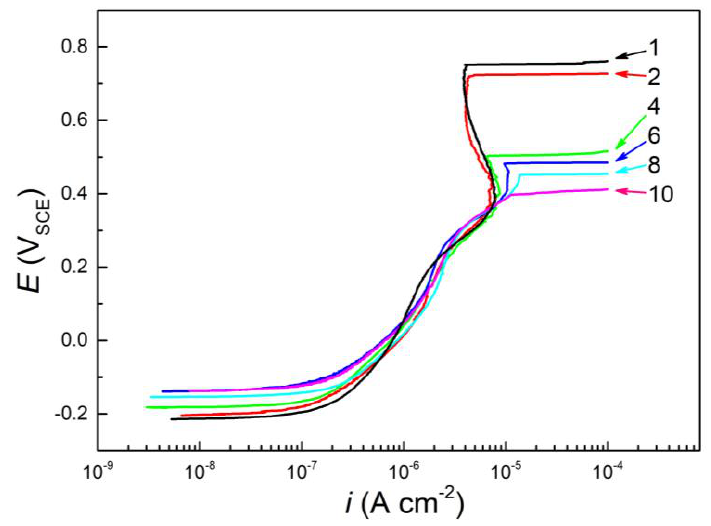
Figure 3. Polarization curves for specimens in the synthetic tap water solutions with different concentration ratios from 1 to 10 times.